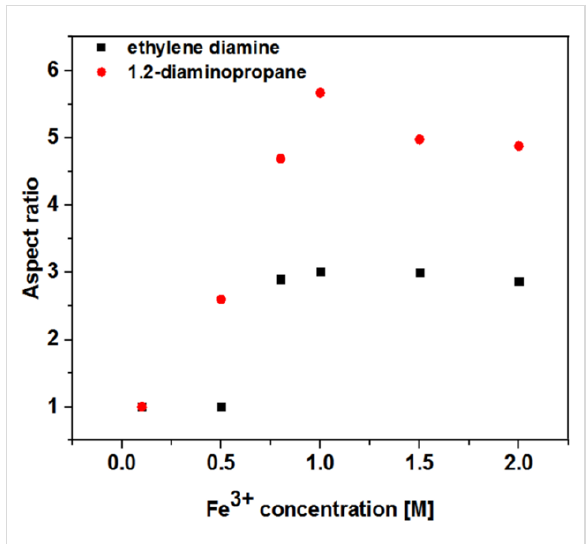
Figure 4: Aspect ratio vs Fe 3+ concentration for α -Fe 2 O 3 nanoparti- cles obtained with 1,2-diaminopropane and ethylenediamine as the SCA (the aspect ratio for spherical particles is set to 1; 20 nanorods were taken for the estimation of the aspect ratio for each Fe 3+ concen- tration; a certain fluctuation margin cannot be excluded especially due to a natural variation in the rod length of about